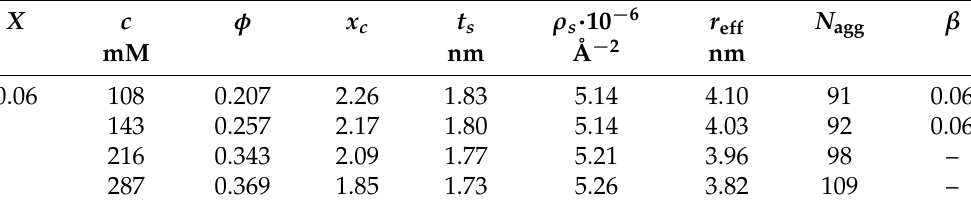
Table 4. Parameters extracted from SANS model fits (core-shell ellipsoid form factor +